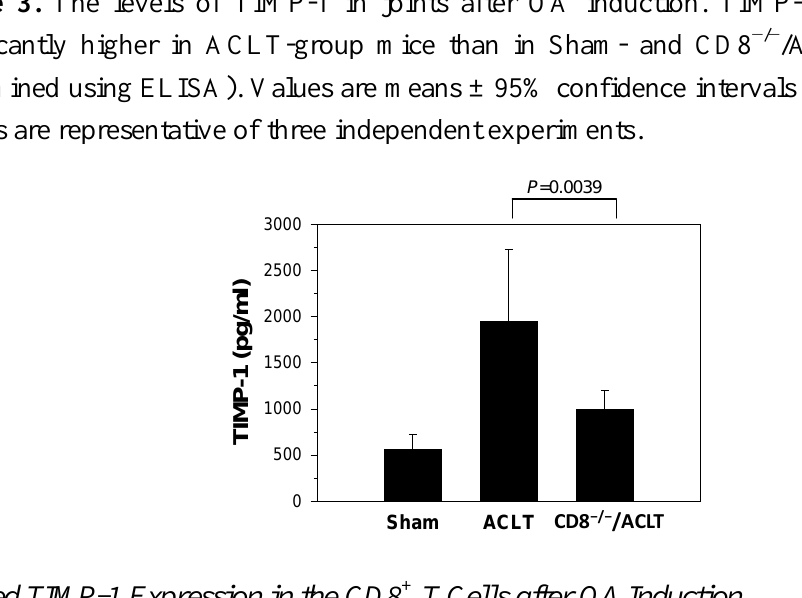
Table 1. Cytokines and cytokine receptor identified by cytokine array analysis. Fold-change * Gene ACLT CD8 −/− /ACLT TIMP-1 1.90 0.75 sTNFRII 0.59 0.86 IL-4 0.76 1.06